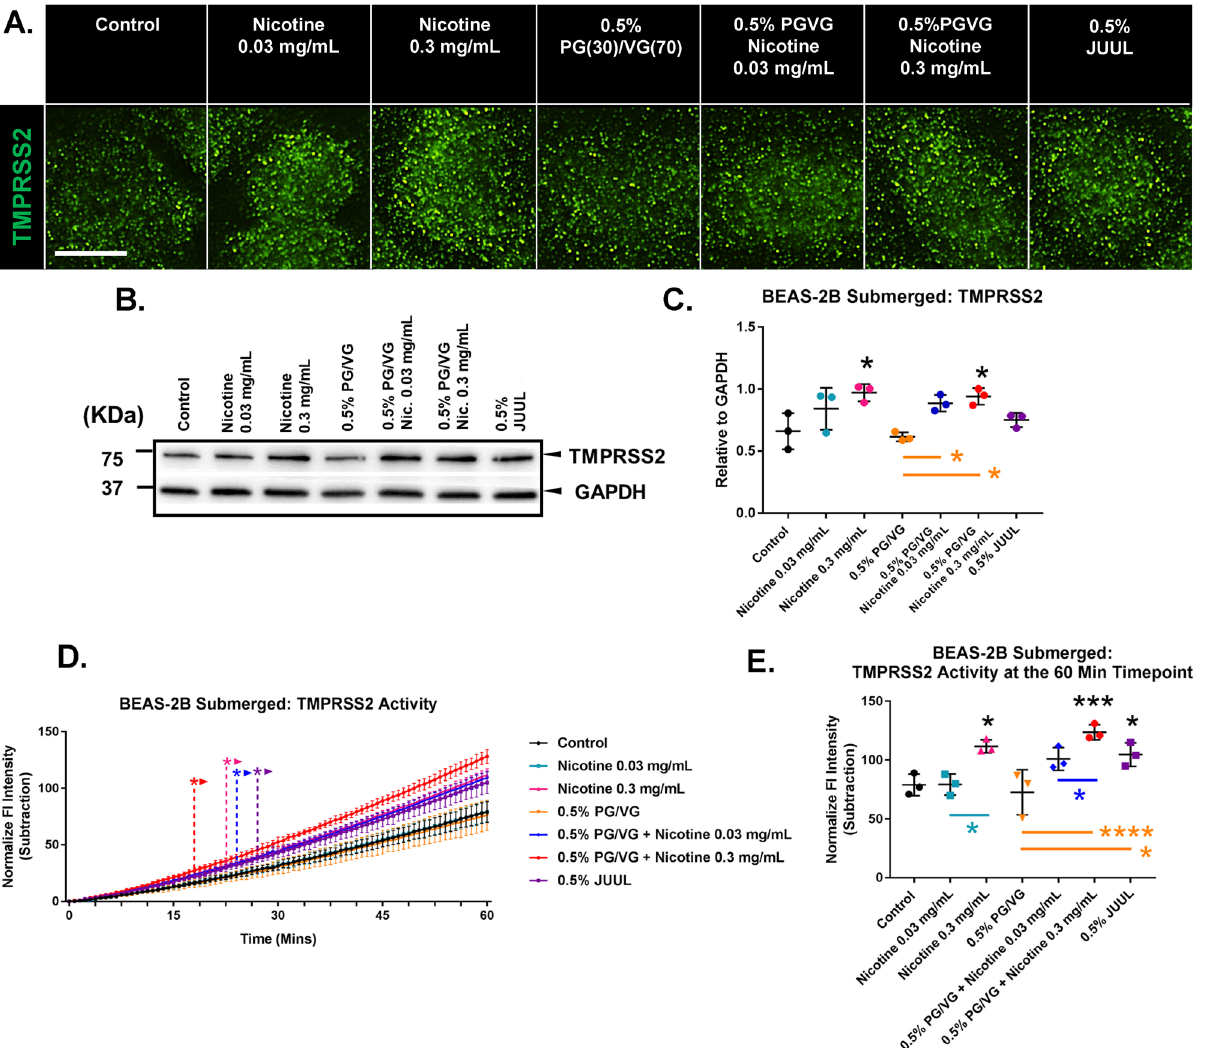
Figure 2. Effect of Juul e-liquid, nicotine, and PG/VG on TMPRSS2 in BEAS-2B cells in submerged culture. ( A ) Micrographs showing cells labeled with TMPRSS2 antibody. Scale bar = 15 µm. ( B – C ) Effect of JUUL e-liquid, nicotine, and PG/VG on TMPRSS2 levels in submerged culture (Western blot). ( D – E ) TMPRSS2 activity was increased by JUUL e-liquid and nicotine following 24 h of treatment in submerged cultures. ( D ) Changes in activity over 60 min. * Indicate when values became significantly different than the control ( p ranged from 0.05 to 0.0001). ( D ) was analyzed using a two-way ANOVA followed by Dunnett’s compared to the control. ( E ) Activity at the 60-min timepoint. All graphs show the mean ± standard deviation of three independent experiments. In C and E Box-Cox transformed data were analyzed using a one-way ANOVA followed by Tukey’s test. Black * = significantly different than the control. Colored * and lines = significantly different groups. * p < 0.05, ** p < 0.01, *** p < 0.001, **** p < 0.0001. Western blots were horizontally cropped from the original